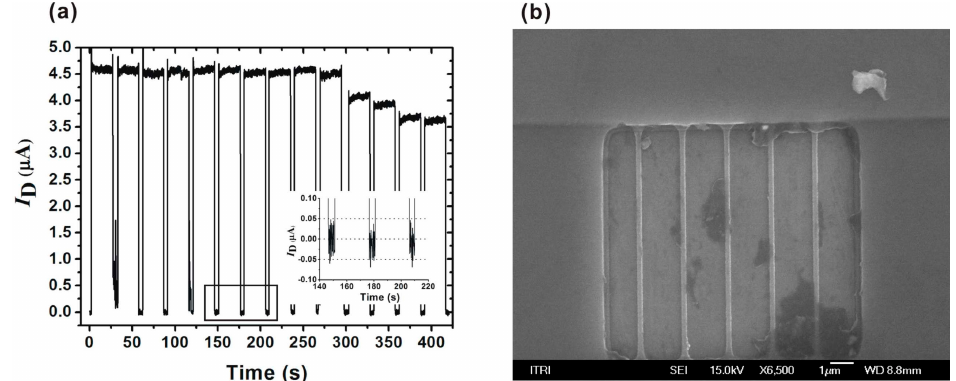
Figure 4. ( a ) Reusability of the proposed sensor; ( b ) Top-view SEM image of the proposed sensor used more than 10 applications.